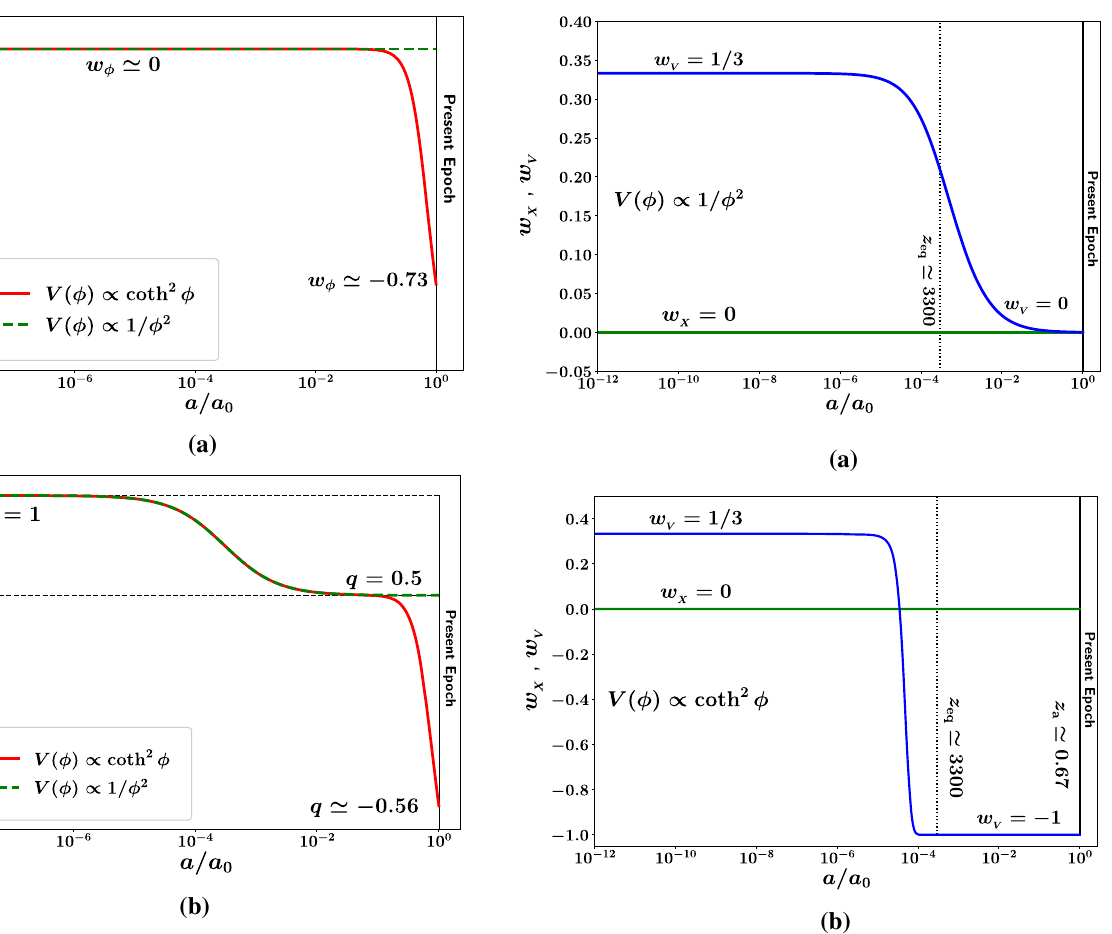
Fig. 5 The evolution of the EOS of the kinetic term w (solid green X (cid:7) (cid:8) (solid blue curve) is shown in a for the curve) and the potential term w 2 (cid:7) (cid:8) V m p (dashed 2 φ m p IPL potential V (φ) = V 0 and b for the coth potential V (φ) = φ (cid:7) (cid:8) φ V 0 coth 2 . For the IPL potential, w scales like the background m p V fluid and never becomes negative, indicating that the universe enters a prolonged matter dominated epoch at late times. By contrast, for the behaves like a scaling solution only at early times coth potential w V = w (cid:2) − 1 at z ∼ 10 4 . For both potentials the ( w ) and drops to w V B V = 0, allowing it to play the EOS of the kinetic term stays pegged at w X role of dark